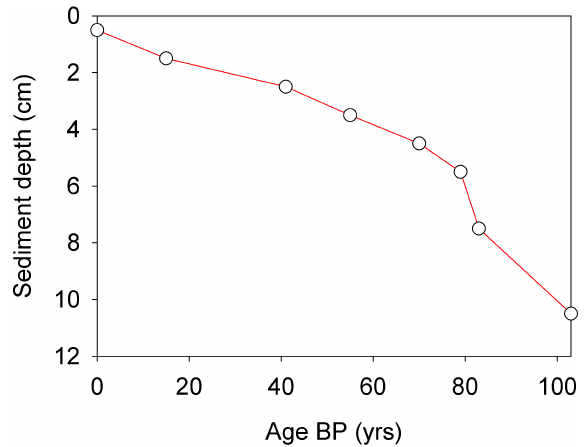
Fig. 1. Depth-age model for the sediment profile from Lake Lyse- vatten based on direct radiometric analyses of sediment using 210 Pb along with 137 Cs, and a constant rate of supply (CRS)